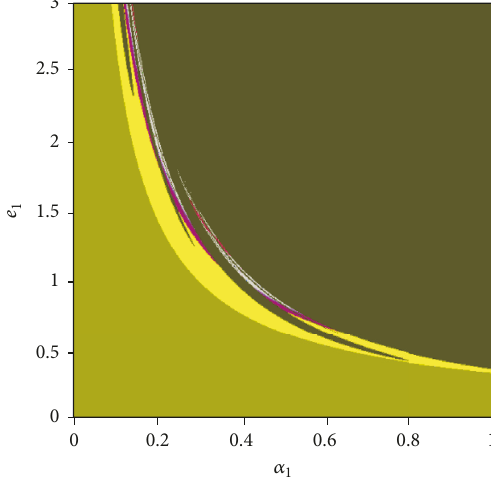
denotes 𝑝 2 (𝑡) , and black set of points denotes 𝑝 3 (𝑡) . As can be seen, system (7) loses its stability when 𝛼 = 0.2 ,